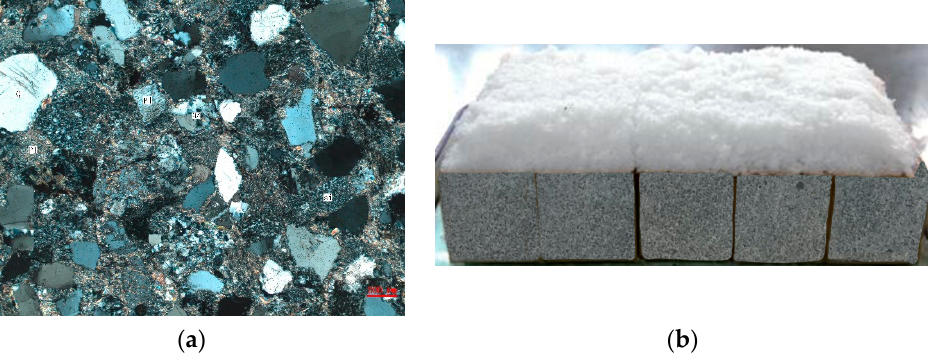
Figure 3. Samples. ( a ) Results of thin section identification test. (Pl: Plagioclase, Q: Quartz, Si: siliceous). ( b ) Samples for melting snow treatment.